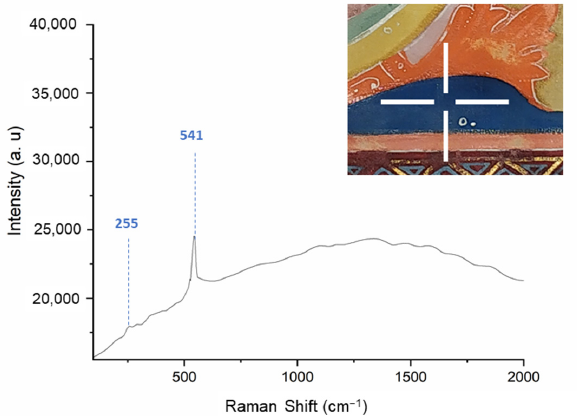
Figure 3. Raman spectrum of the blue background of the initial “P” (displayed inside the white cross). The peaks of ultramarine are reported in blue colour.